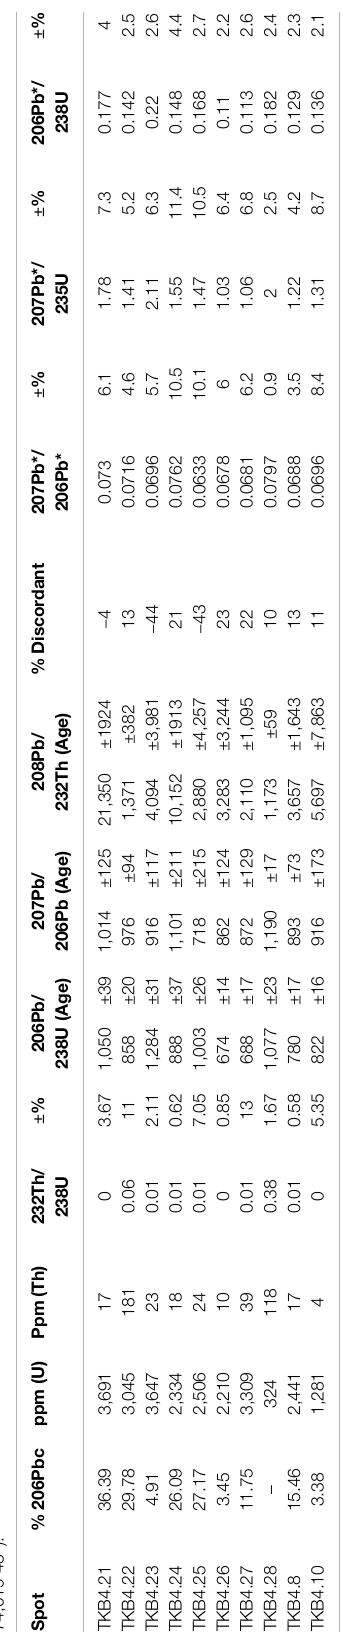
Na 2 O compared to K 2 O characterize the Pratapgarh granite. It shows A/NK > 1.0 and the A/CNK values < 1.0 ( Table 2 ). The CIPW norm shows these are quartz, diopside, albite, and ilmenite normative. The samples lie in the meta-aluminous fi eld of the A/NK vs. A/CNK plot ( Figures 5A, I type fi eld of the Na 2 O vs. K 2 O and TiO 2 vs. Zr plot ( Figures 5B,C ) (Chappell and White, 1992) and calc-alkaline fi eld in Na 2 O + K 2 O-CaO vs. SiO 2 plot ( Figures 5D ) (cf. Frost et al., 2001). The (La/Lu) N is 0.11 – 0.13 suggesting low degree of REE differentiation and Eu/Eu* value is 0.53 and 0.62 suggesting -ve Eu anomaly ( Table 2 ). Rb vs. Y + Nb plot indicates “ within plate magmatism ” ( Figure 5E ) (Pearce, T A